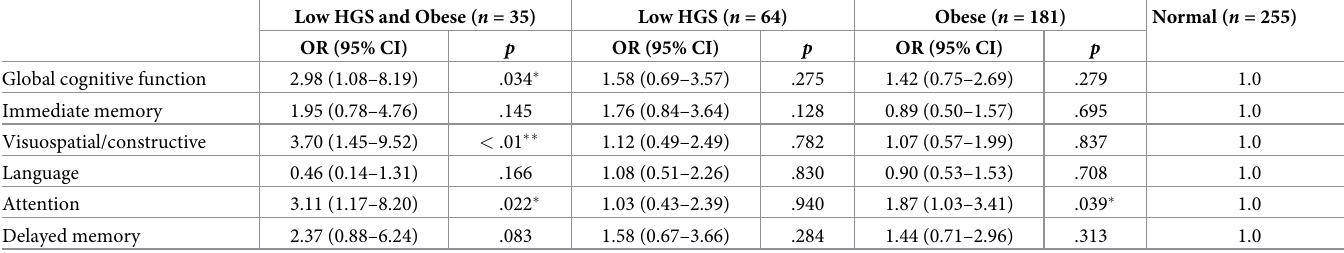
Table 4. Association between handgrip strength, obesity, and risk of impairment in different domains of cognitive function.